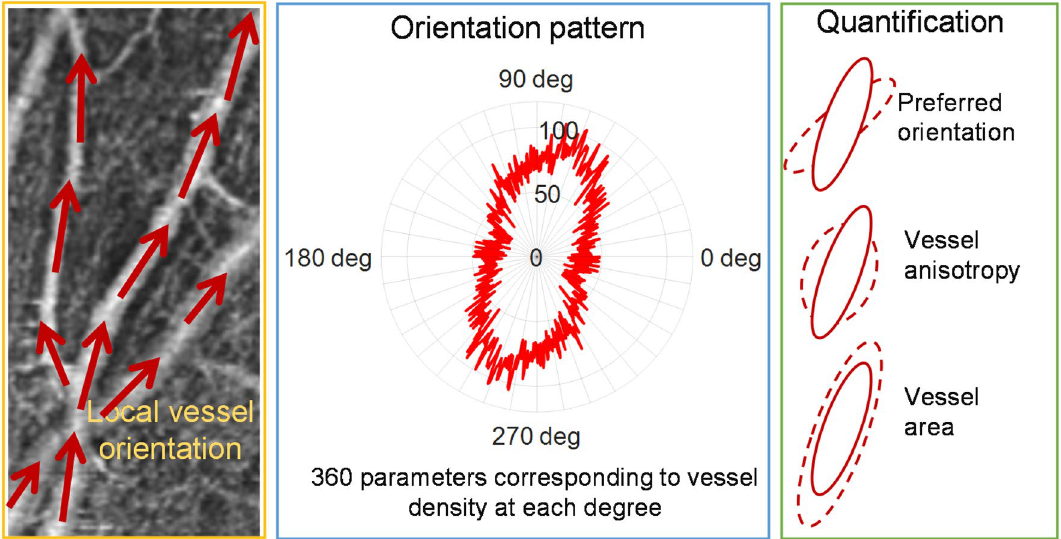
Figure 4. Quantification of vascular orientation pattern using preferred orientation, vessel anisotropy, and vessel area. The orientation pattern (middle) for the specific ROI (left) depicts a roughly elliptical shape with a major axis and a minor axis. The preferred orientation is identified by the angle of the major axis. The ratio of major axis length and minor axis length is defined as vessel anisotropy. The vessel area is defined as the area of the shape. Examples of preferred orientation, vessel anisotropy, and vessel area, are illustrated by the dashed ellipse relative to the solid ellipse